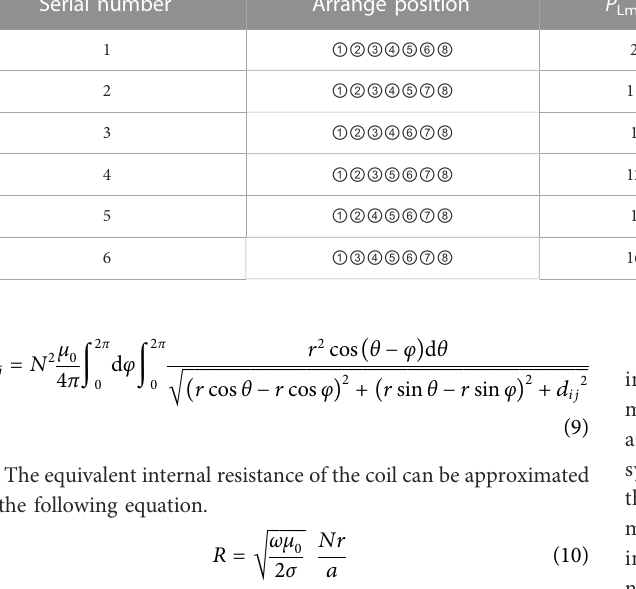
TABLE 2 Parameters of the system when the coils are arranged in different position. Serial number Arrange position P Lmax